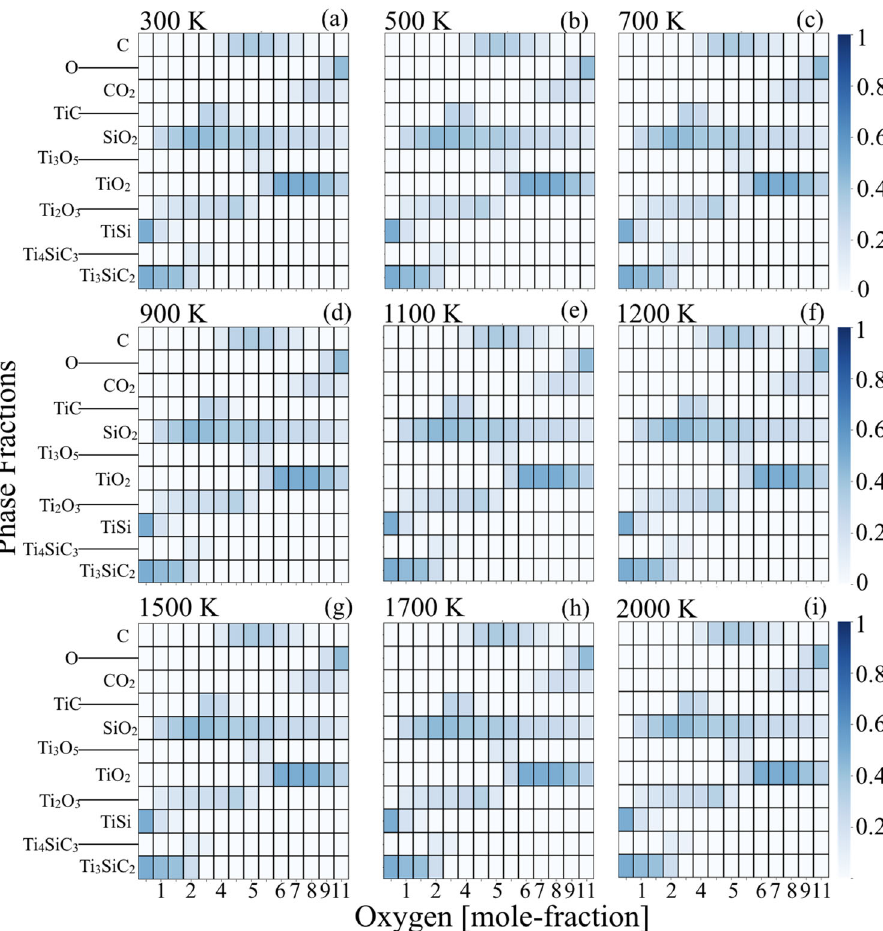
Fig. 3 Competing phases and phase-fraction of Ti 2 SiC + O 2 MAX phase. a – i Phase fractions of [Ti 2 SiC + O 2 ] reaction products at different temperatures with changing molar percent oxygen (0 – 11 moles). The color gradient (shades of blue) shows molar phase fractions. Blank spot [white (0)] suggests no phases. Note that Ti 2 SiC never belongs to the convex hull, which has zero phase fraction at all oxygen mole